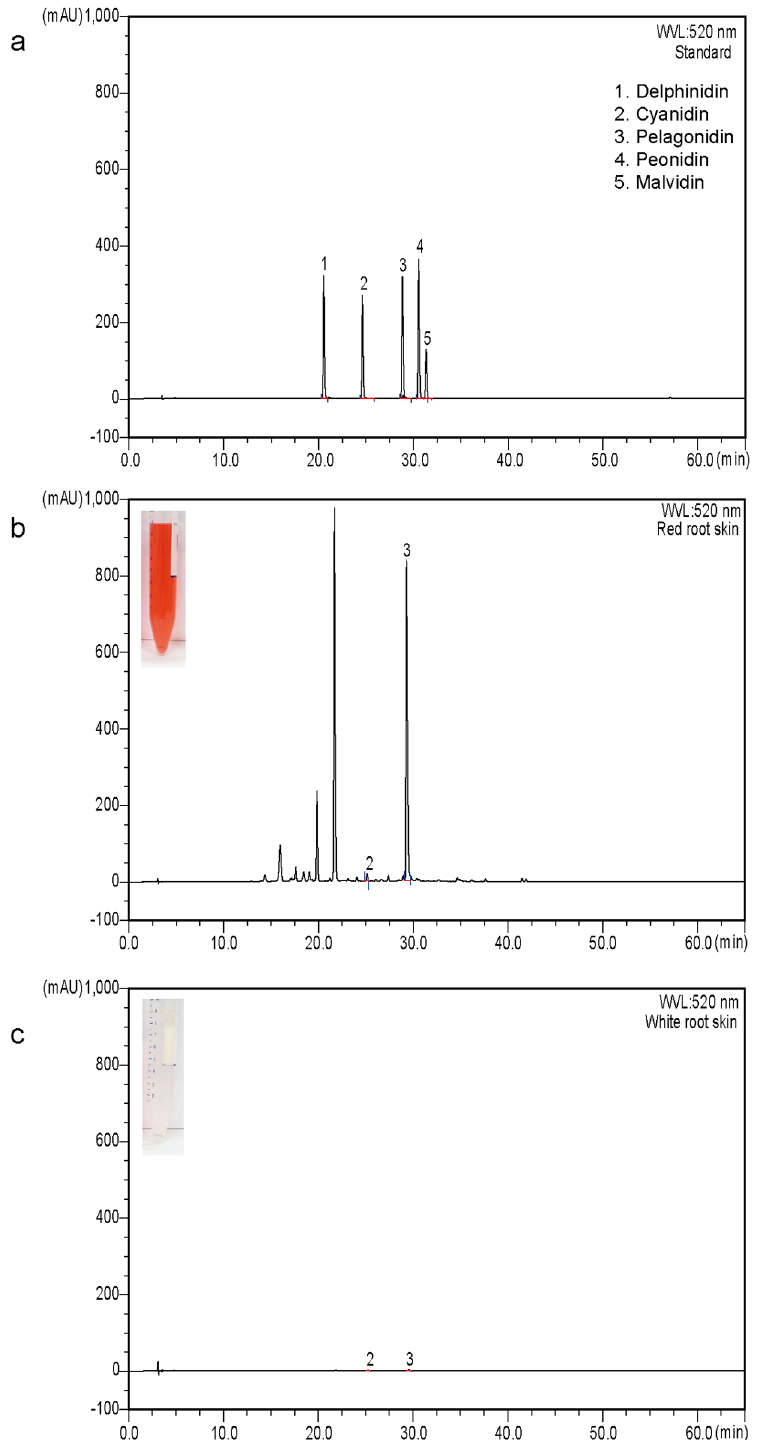
Fig 2. Pelargonidin is a major anthocyanidin in red root skin. HPLC analysis with standards (a), and root skin extracts of red (b) and white roots (c). Pictures for methanol extracts from the red and white root skins were depicted in inlets in (b) and (c),